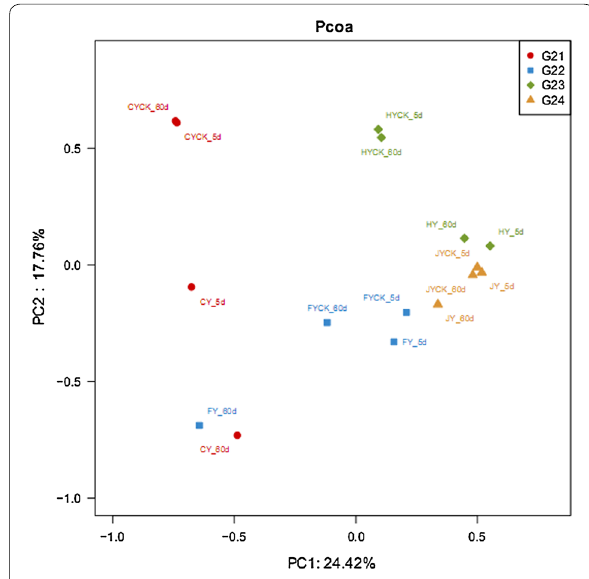
Fig. 5 Fungal PCoA analysis results in